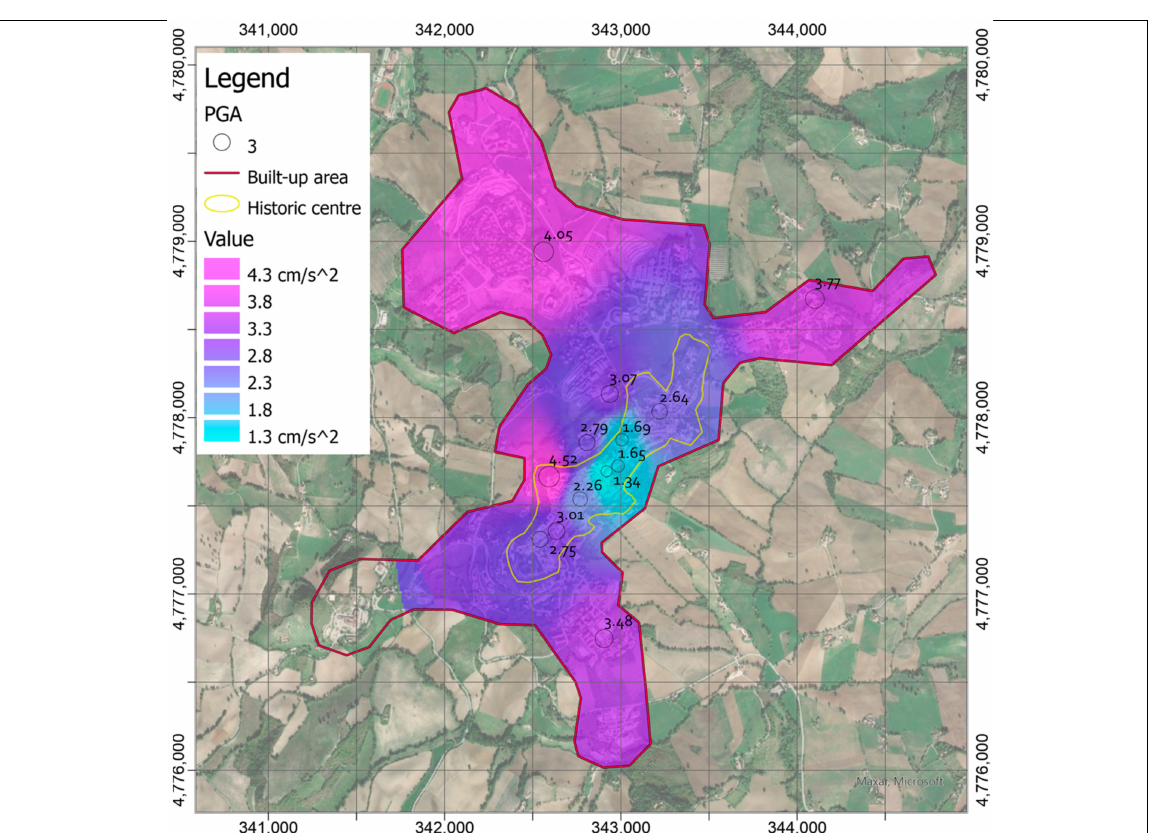
Figure 8. Local shakemaps in terms of PGAs (in cm/s 2 ) obtained by Inverse Distance Weighted (IDW) interpolation with power coefficient set to 4.